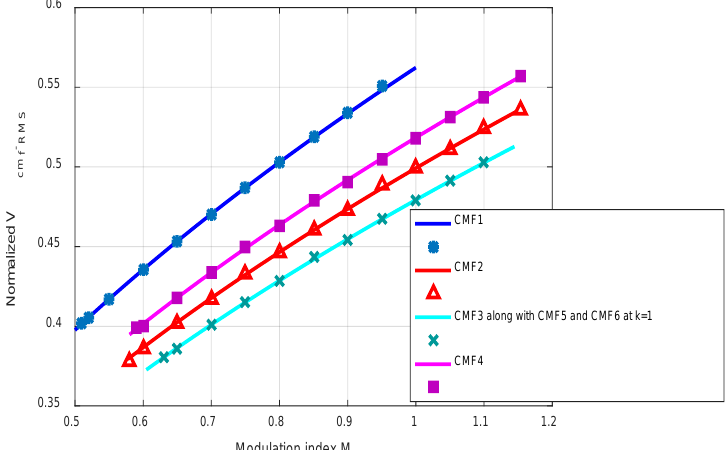
Figure 21. RMS-CMV per V dc Versus M. solid lines: theoretical results, marks: simulation